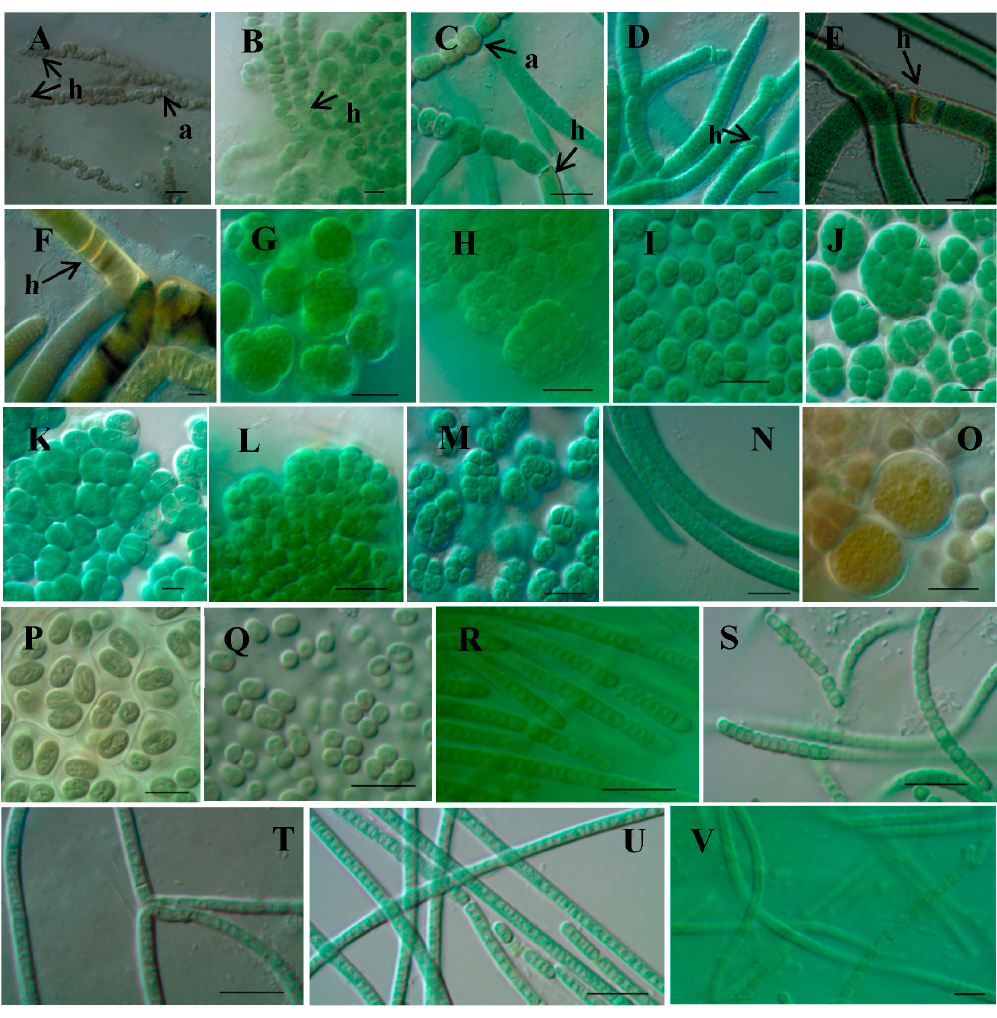
Figure 3. Light micrographs of strains. ( A ) Ru1-3d, ( B ) Ru1-6, ( C ) Ryu2-7DN(D3), ( D ) Ryu5-18(F2), ( E ) Ryu1-11, ( F ) Ryu1A1(C3), ( G ) Ryu4-7, ( H ) Ryu9.1-2, ( I ) Ru3-14, ( J ) Ryu8-6, ( K ) Ryu1-3, ( L ) Ryu2-16, ( M ) Ryu5-15d, ( N ) Ru5-34, ( O ) Ru3-1, ( P ) Ryu1-8DN(B9), ( Q ) Ryu4-4DN(I7), ( R ) Ru3-34, ( S ) Ryu1-2, ( T ) Ru5-44, ( U ) Ryu2-12, ( V ) Ru4-3d. a: akinates, h: heterocysts. Scale bars = 10 µm.